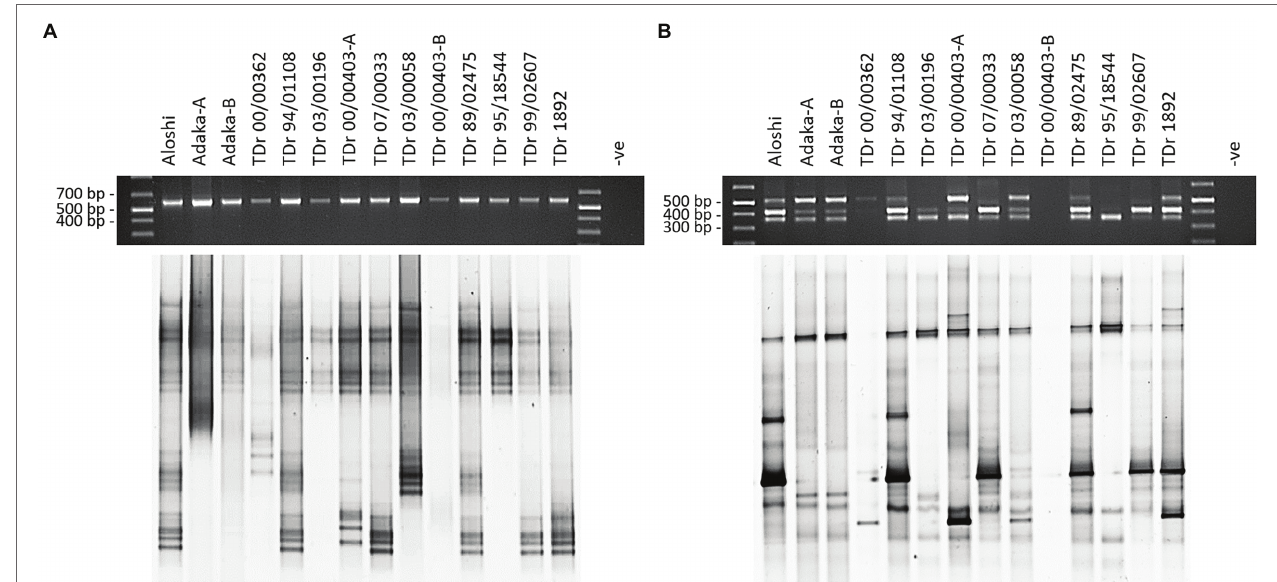
FIGURE 3 | Comparison of PCR and DGGE analysis of partial RT-RNaseH badnavirus sequences amplified by Badna-PCR versus species-specific group multiplex Badna-PCR. Samples shown represent two landraces (Aloshi and Adaka) and ten breeding lines of D. rotundata (TDr) amplified by Badna-PCR (A) or species- specific group multiplex Badna-PCR (B) . Badna-PCRs (A) used BF-GC and Badna-RP primers, whereas multiplex PCR amplifications (B) used primers BF-GC, K8-R, K9-R and U12-R producing expected amplicon sizes of 619 bp (Badna), 387 bp (K8), 447 bp (K9) and 565 bp (U12) on a 1.5% (w/v) agarose gel (black gels on top) before DGGE loading (bottom gels). The denaturing gradient was 35–50% and DGGE was performed at 80 V at a temperature of 60 ° C for 18 h. Samples TDr 00/00403-A and -B and Adaka-A and -B are clones of the same yam accessions. -ve: non-template control of the